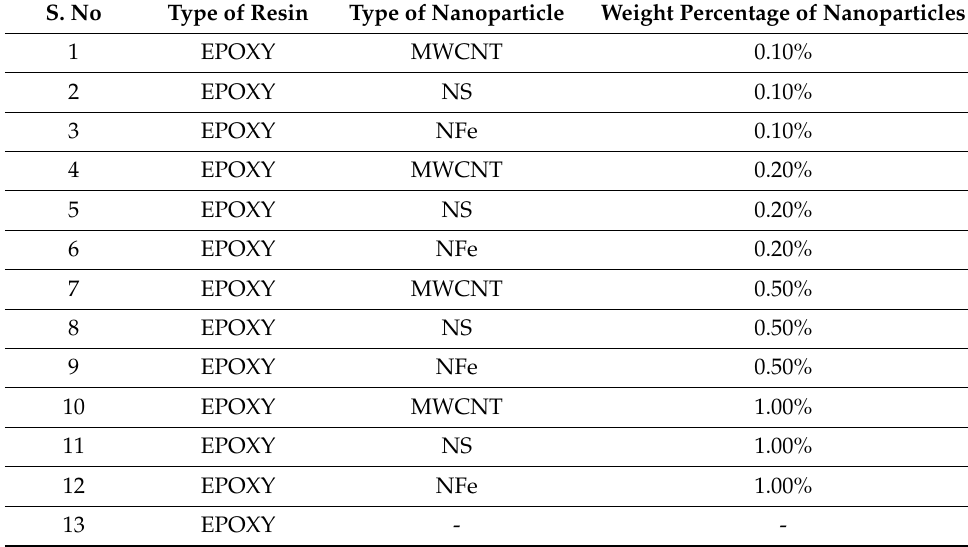
Table 2. Different compositions used in sample